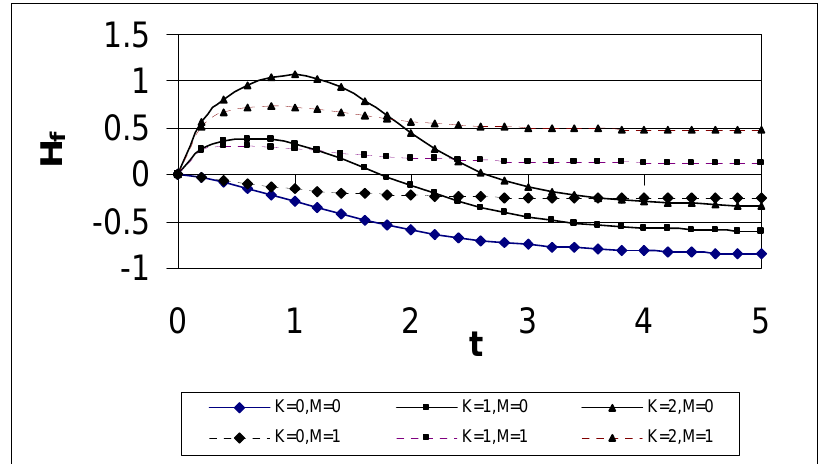
Fig. 1. Time growth of the axial velocity component at infinity H for various values of the parameters K and M.